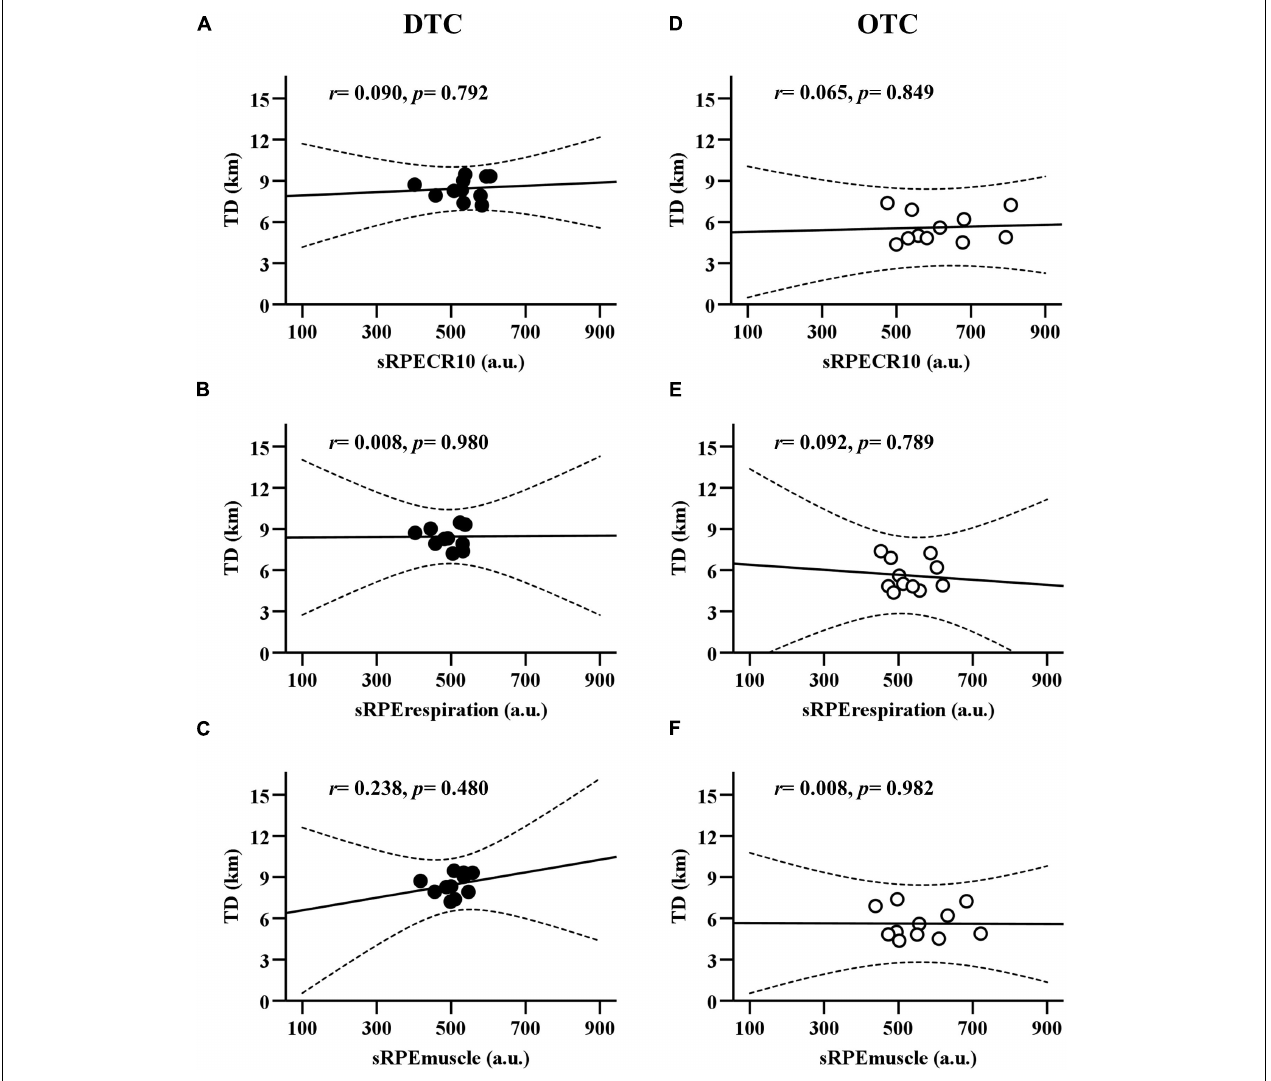
FIGURE 4 | The linear regression between the RPE (RPE CR10 , RPE respiration , and RPE muscle ) and the total distance covered during domestic and overseas training camps. (A) Comparison between TD and sRPE CR10 during DTC. (B) Comparison between TD and sRPE respiration during DTC. (C) Comparison between TD and sRPE muscle during DTC. (D) Comparison between TD and sRPE CR10 during OTC. (E) Comparison between TD and sRPE respiration during OTC. (F) Comparison between TD and sRPE muscle during OTC. TD, total distance covered; sRPE CR10 , session rating of perceived exertion CR10; RPE respiration , session respiratory perceived exertion; RPE muscle , session muscular perceived exertion; DTC, domestic training camps; OTC, overseas training camps.